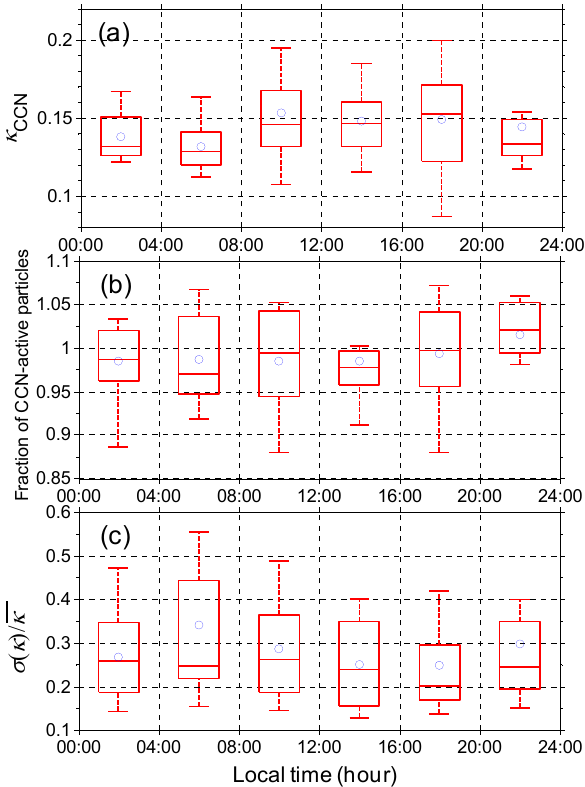
Fig. 2. The diurnal variations of (a) the average hygroscopicity, (b) maximum activation fraction, and (c) dispersion of size-selected CCN active particles ranging from 100 to 171nm. The ends of the whiskers represent the minimum and maximum of data except for the outlines, which are defined as points outside of ± 2.7 σ . The bot- tom and the top of the box are the 25th and 75th percentiles, the line inside the box is the 50th percentile, and the blue circle represents the mean